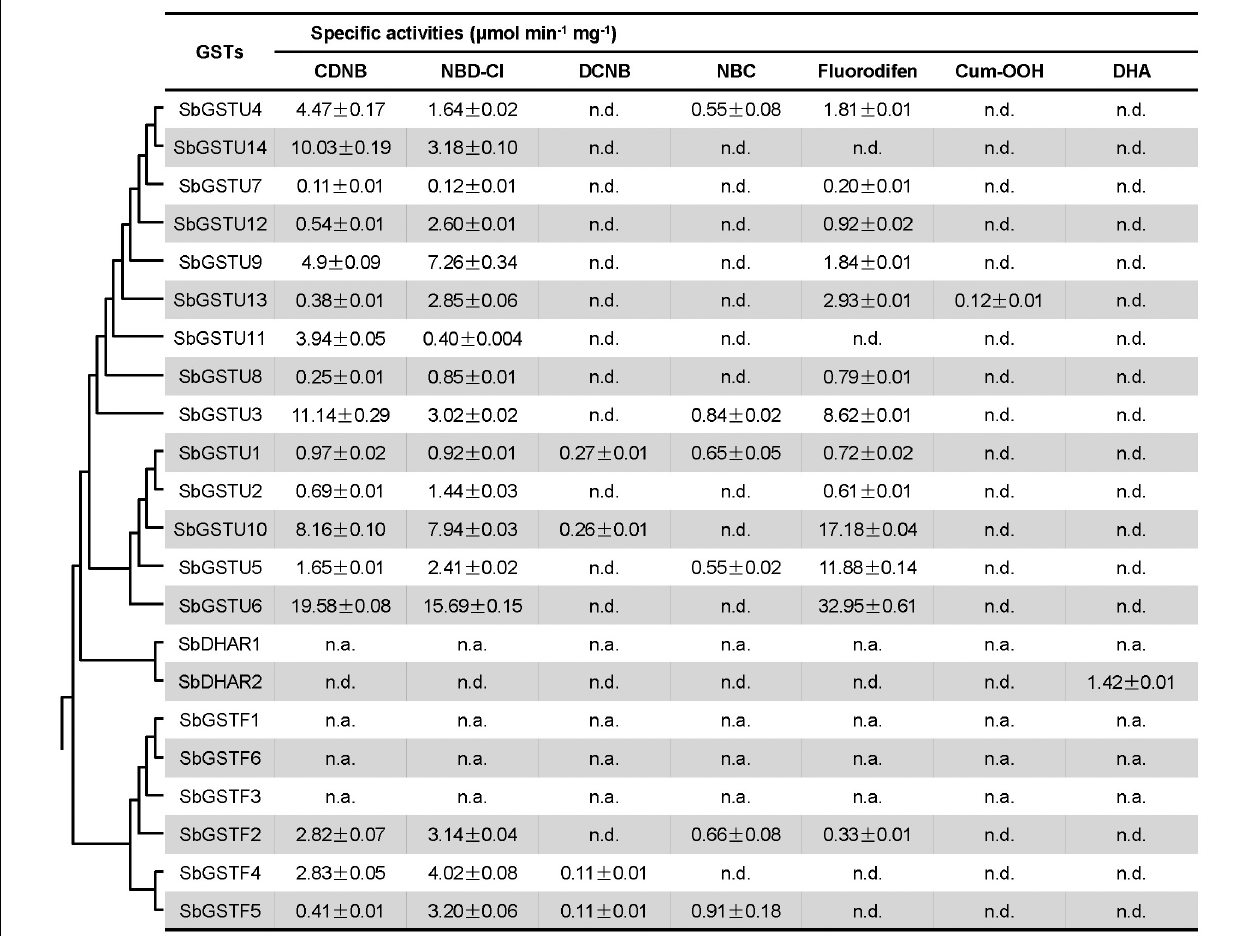
TABLE 2 | Steady-state kinetic parameters of Salix tau GSTs.